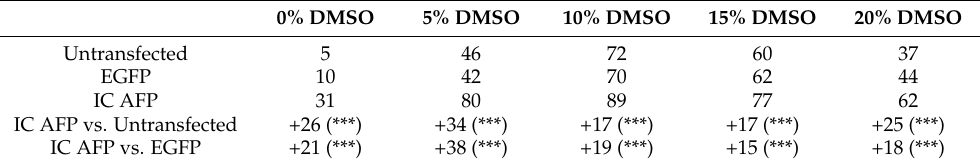
Table 1. Average % viability of HEK 293T cells across treatments as determined by trypan blue assay. 0% DMSO 5% DMSO 10% DMSO 15% DMSO 20% DMSO Untransfected 5 46 72 60 37 EGFP 10 42 70 62 44 IC AFP 31 80 89 77 62 IC AFP vs. Untransfected +26 (***) +34 (***) +17 (***) +17 (***) +25 (***) All experiments contained 3 biological repeats ( n = 3), with each containing 3 technical repeats. *** IC AFP vs. EGFP +21 (***) +38 (***) +19 (***) +15 (***) +18 (***) p ≤ 0.001.